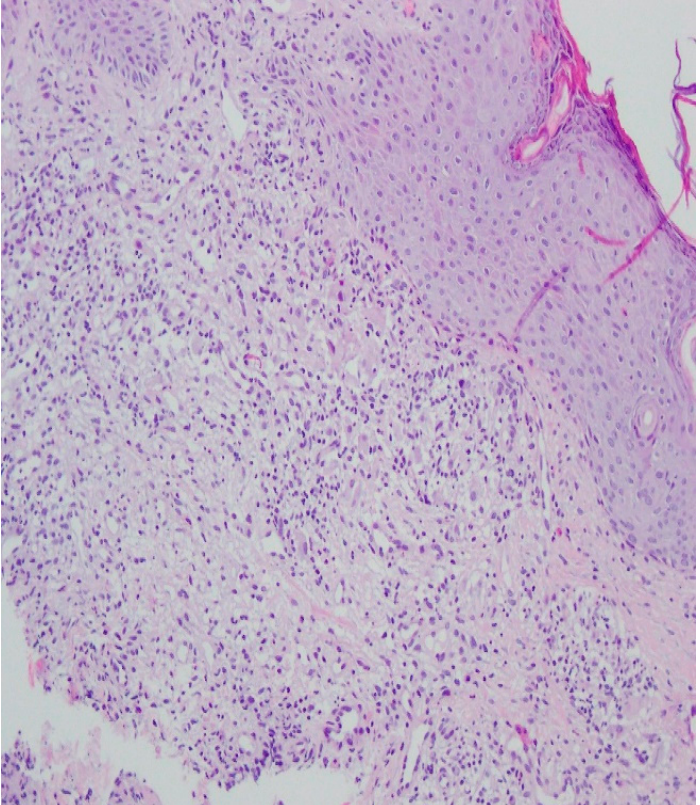
Figure 8. Thickened non-regular epidermis with streaky swelling, thinned by lymphocytic and histiocytic inflammatory infiltration with single plasmacytes. Slightly thicker infiltration in the area of enlarged vessels of the superficial plexus. Lack of characteristics typical for active pyoderma gangrenosum. The clinical picture can be consistent with secondary/tertiary syphilis.